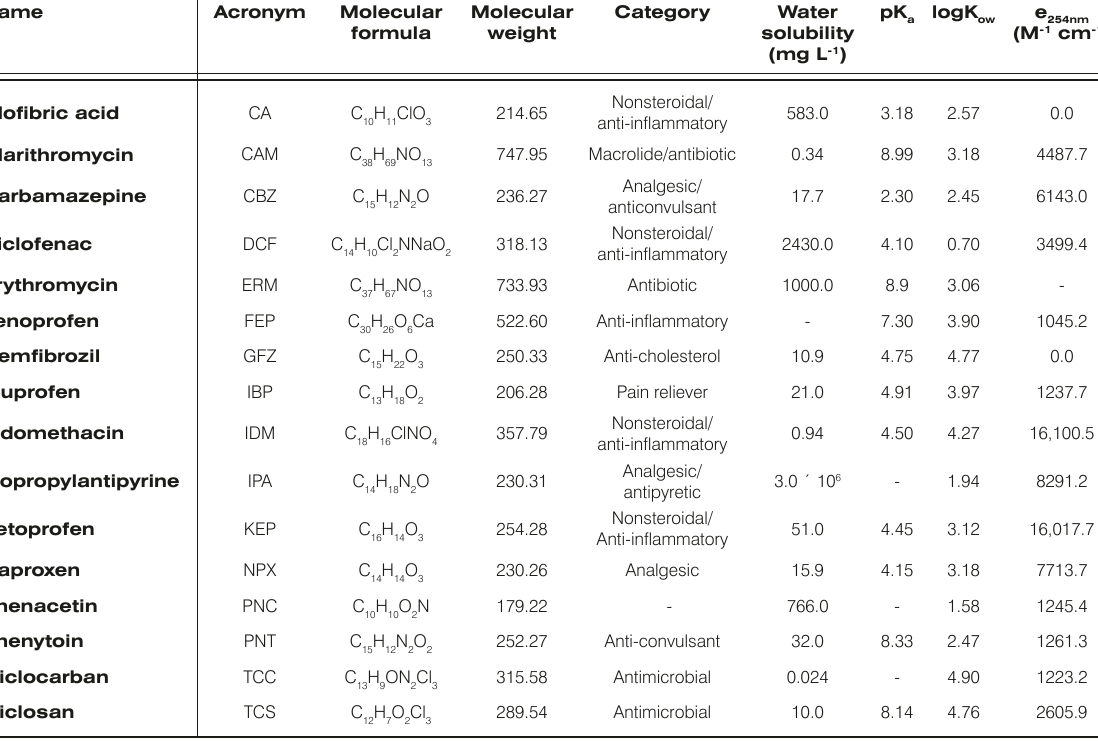
Table 1. Investigated compounds and their